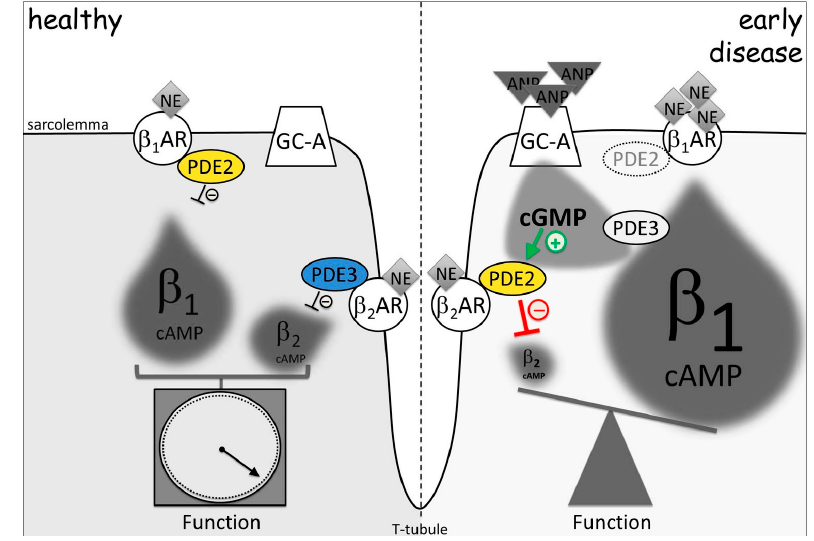
Figure 3. PDE2 and PDE3 redistribution in early cardiac hypertrophy changes cGMP-to-cAMP cross-talk. β 2 -AR microdomain is normally controlled by PDE3, while PDE2 is functionally associated with β 1 -AR. In disease, redistribution of PDE2 from β 1 - to β 2 -AR-associated membrane microdomains leads to a decrease of the local β 2 -AR-cAMP and to an increase of global β 1 -AR-cAMP pool under elevated ANP and cGMP levels observed in hypertrophy. This relocation of cGMP-regulated PDEs leads to a turnaround of cGMP-to-cAMP cross-talk between both β -AR microdomains. By this mechanism, elevated ANP can augment β -adrenoceptor-stimulated contractile function. NE: norepinephrine, the physiological β -AR agonist. Adapted from [158].